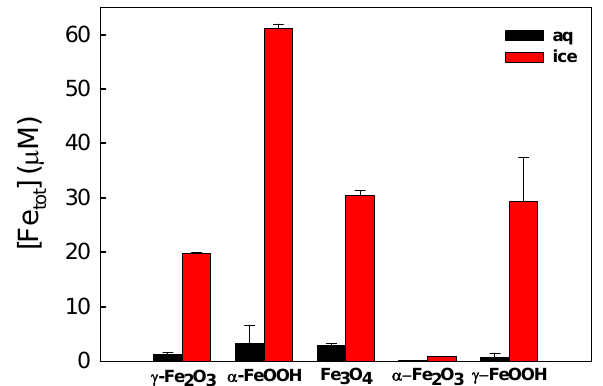
Fig. 2. Dissolved iron formation from various iron oxides in the absence of organic complexing ligand under dark condition. Aqueous samples (black) were maintained at room temperature and ice samples (red) at -20 o C for 72 h. Experimental conditions: [iron oxide] = 0.2 g L -1 and pH i = 3.00 ± 0.05.